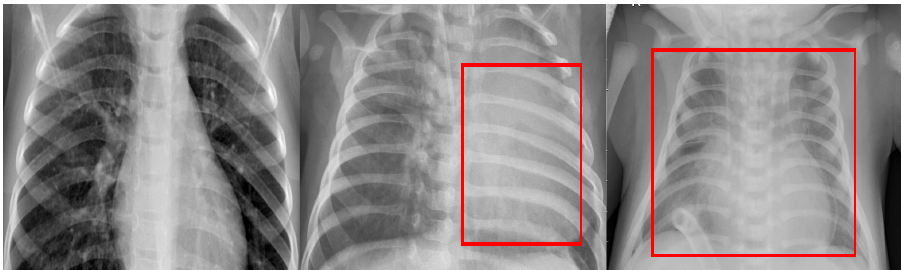
Figure 1. Examples of three CXR images of child human lungs. The left-hand image represents a healthy case, the middle image depicts a viral infection, while a lung with a bacterial infection is shown on the